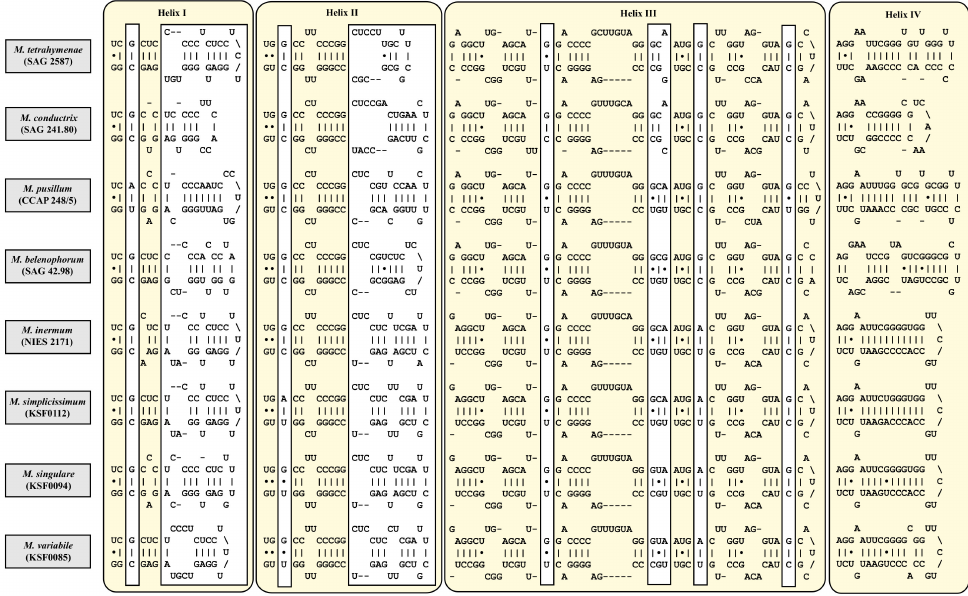
Figure 6. Variability of ITS-1 among the eight Micractinium